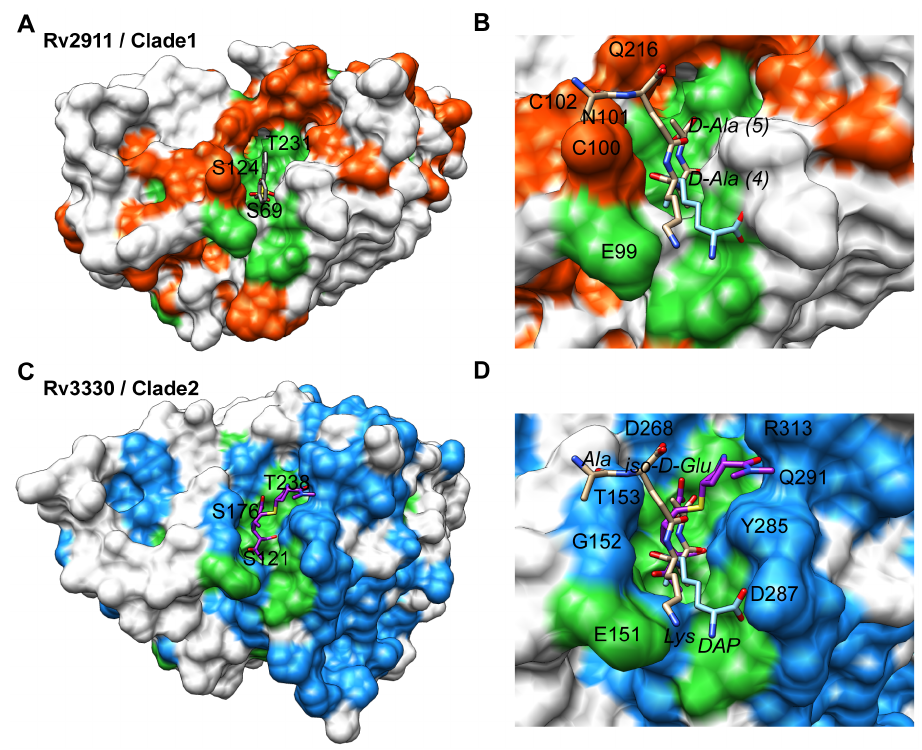
Fig. 5. Different conserved surfaces surround the catalytic site in Clade 1 and Clade 2 D,D- carboxypeptidases. A. Surface representation of Rv2911 opt -PMSF showing regions conserved across the two clades (green, 100% identity) as well as clade-specific conserved surfaces (orange, at least 90% identity within Clade 1). Surfaces corresponding to residues in the three conserved active site motifs are labeled to establish orientation. B. Catalytic site of Rv2911 (colored as in A) showing the superposition of stem-peptide mimicking ligands from E. coli PBP6 (tan, PDB 3ITB) and B. subtilis PBP4a (light blue, PDB 2J9P). The site that distinguishes lysine (tan) from DAP (light blue) is conserved at the bottom of the figure. PMSF was omitted for clarity. C. Rv3330-meropenem surface representation showing surfaces conserved across the two clades (green) and across Clade 2 (blue, at least 90% identity within Clade 2). A large surface (300 A˚ 2 ) on the lower right in the figure is conserved in Clade 2 enzymes. D. The catalytic site of Rv3330 bound to meropenem (purple) with stem-peptide mimics from the superimposed complexes of E. coli PBP6 (tan, PDB 3ITB) and B. subtilis PBP4a (light blue, PDB 2J9P). The donor-peptide mimic (tan) exits the active site to the upper left of the figure. In contrast, meropenem interacts with a surface conserved in Clade 2 (upper right).